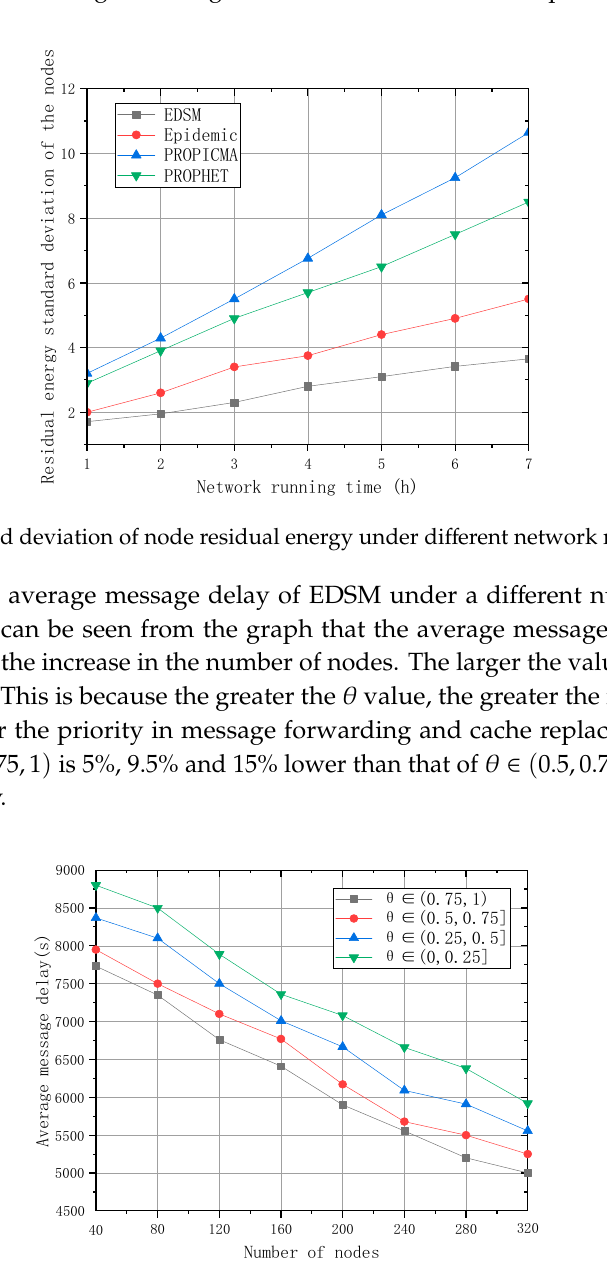
Figure 3. Average Message Delay in Different θ Intervals.